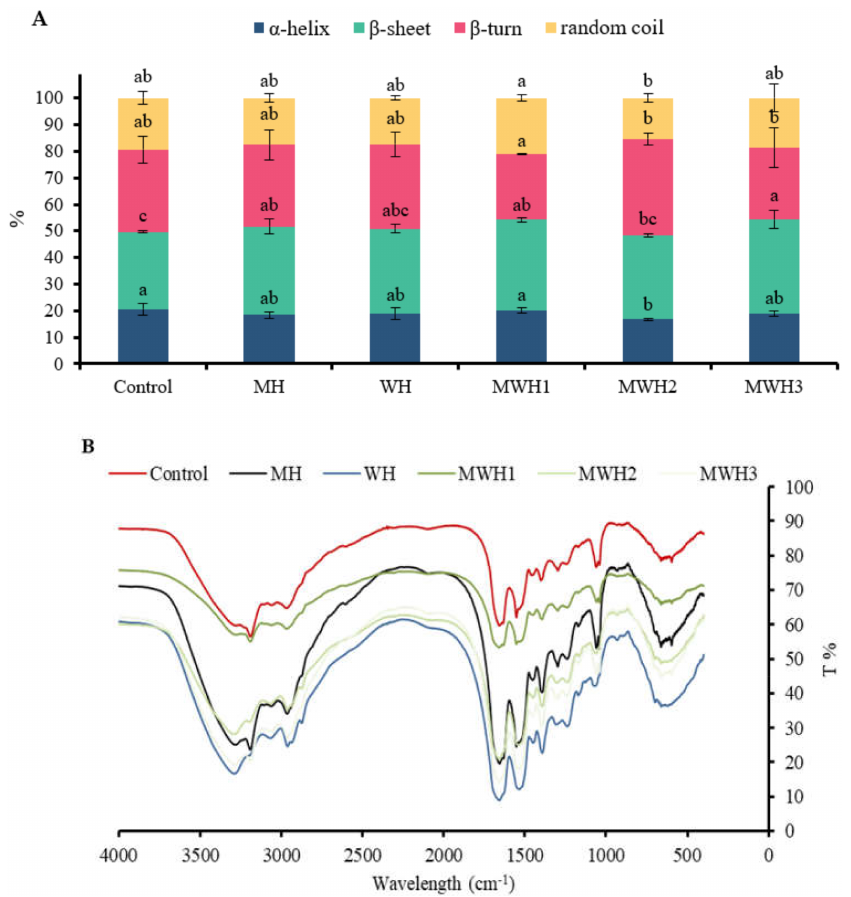
Figure 5. ( A ) Changes in the secondary structure of myosin under different heating conditions. Values with different lower-case letters (a–c) are significantly different ( p < 0.05). ( B ) Fourier transform infrared spectroscopy of SCM with different heating